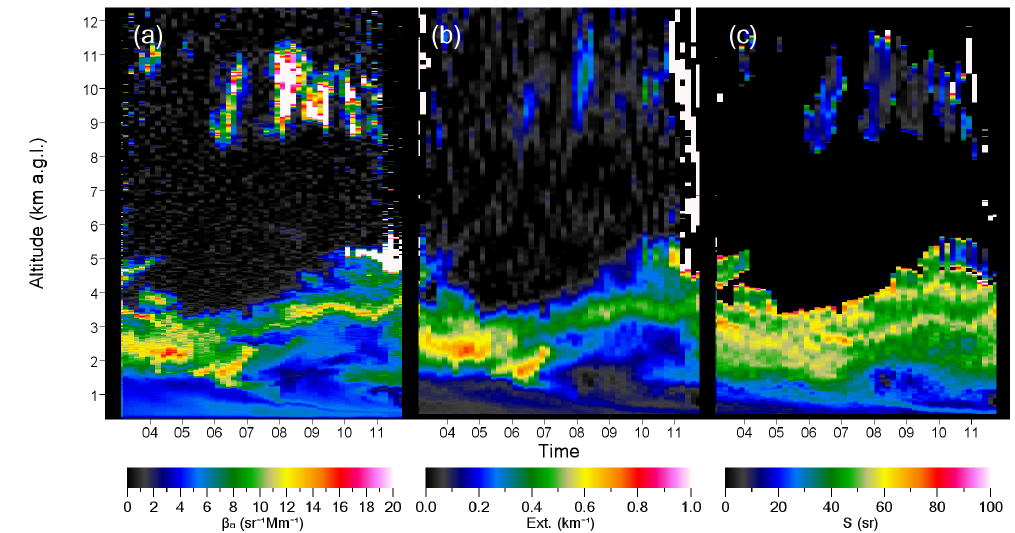
Figure 16. Three-panel plot showing the backscatter coefficient, extinction coefficient and S ratio for 31